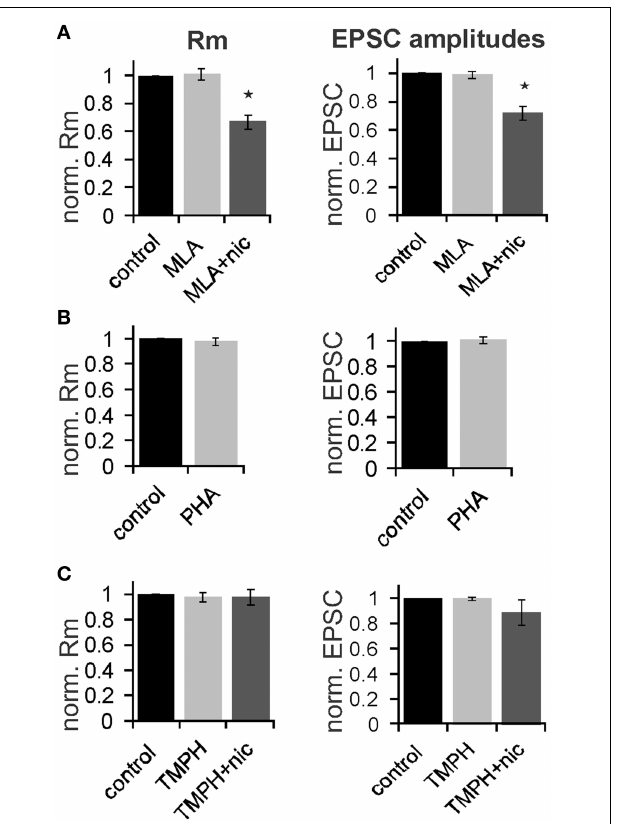
FIGURE 7 | The effect of nicotine on PnC giant neurons is mediated by non- α 7-nicotine receptors. (A) Effect of the α 7nAChR preferring antagonist MLA (100nM). Membrane resistance (Rm) was normalized to the resistance of each cell under control conditions. MLA alone had no effect on Rm, however, the effect of nicotine persisted in presence of MLA. MLA alone did also not affect EPSC amplitudes, whereas nicotine reduced synaptic currents in presence of MLA ( n = 4 cells, only trigeminal EPSC amplitudes were analyzed). (B) Effect of the α 7 specific agonist PHA543-613 (30 μ M) on Rm and EPSC amplitudes: PHA 543-613 had no effect on PnC giant neurons ( n = 6 and n = 4, respectively). (C) Effect of the non- α 7 preferring antagonist TMPH (100nM): TMPH alone had no effect on Rm or EPSC amplitudes. In presence of TMPH, nicotine did also not affect Rm and synaptic currents, indicating that TMPH antagonizes the nicotine effect. Asterisk marks statistical significance with p < 0 . 05 ( n = 6